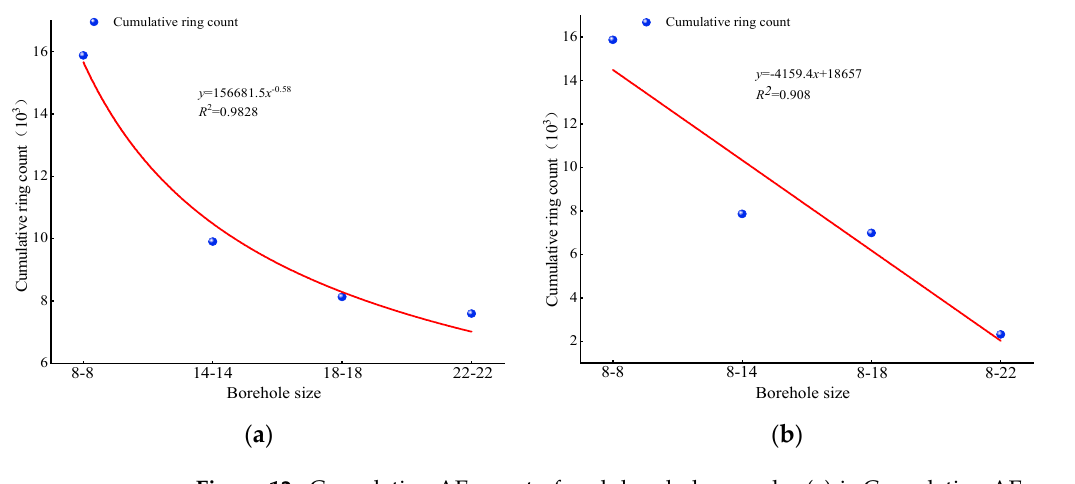
Figure 12. Cumulative AE count of each borehole sample: ( a ) is Cumulative AE count of same-diameter drilling samples; ( b ) is Cumulative AE count of variable-diameter drilling samples.